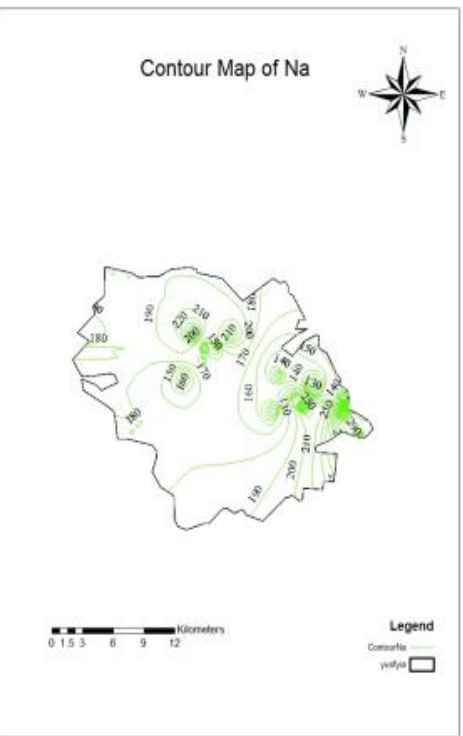
Fig.7: The interpolation and contour line of Na map in